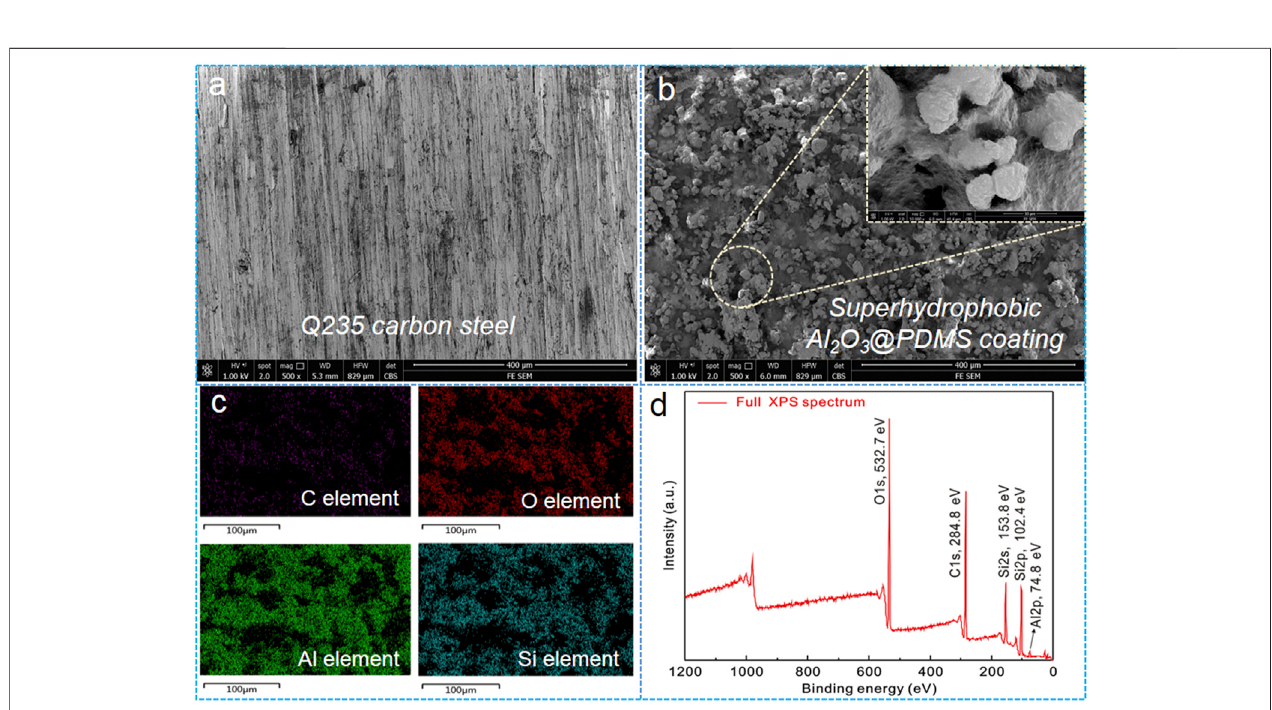
FIGURE4|(A,B) FE-SEMimages ofthebare Q235carbon steel and thesuperhydrophobic Al 2 O 3 @PDMScoating, (C) EDS mappings, and (D) fullXPSspectrum of the as-prepared superhydrophobic Al 2 O 3 @PDMS